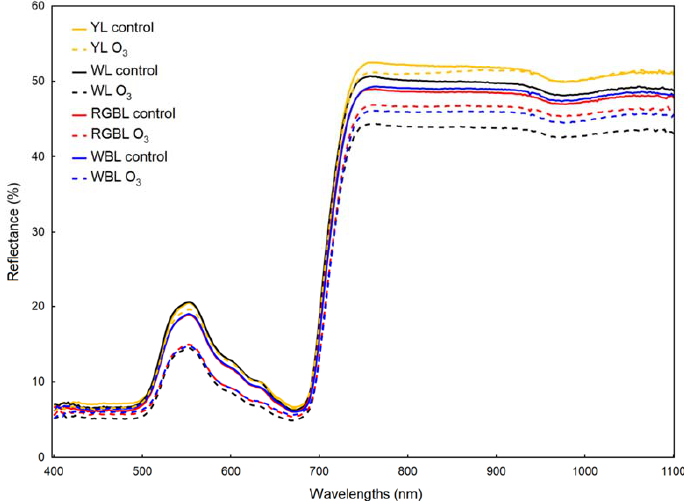
Figure 2. Leaf reflectance spectra of Brassica rapa subsp. pekinensis after 21 days of growth in 100-ppb O 3 or not fumigated (control) in different light spectra: YL—yellow light (sodium lamp), WL—white light, RGBL—light with a dominant red component and WBL—light with adominant blue component. Average values from 7 independent replications. The spectral composition of light significantly affected the changes in the content of protective dyes such as anthocyanins and flavonols. The total anthocyanins pool ex ‐ pressed by the ARI 2 value increased under the influence of O 3 in plants from all spectral compositions, except for RGBL, with the highest increase observed in YL plants (Table 3). After 21 days of O 3 treatment, the anthocyanin content in YL and WL plants was similar. A very large increase in the content of flavonols (FRI) after ozone exposure took place in leaves growing under WBL. In the case of YL, WL and RGBL plants, this increase was significantly smaller (Table 3). The structure independent pigment index (SIPI) did not differ between treatments. Additionally, tissue hydration (water band index—WBI) was not dependent on light conditions and exposure to ozone (Table 3). Table 3. Reflectance parameters from the leaves of Brassica rapa subsp. pekinensis growing in a different light spectrum and treated with ozone (100 ppb, 21 days) or non ‐ fumigated (control). YL—yellow light (sodium lamp), WL—white light (LED), RGBL—red + green + blue light (LED) and WBL—white + blue light. Average values (±SD) marked with the same letters in the row do not differ significantly according to Duncan’s test, p ≤ 0.05, n = 7.